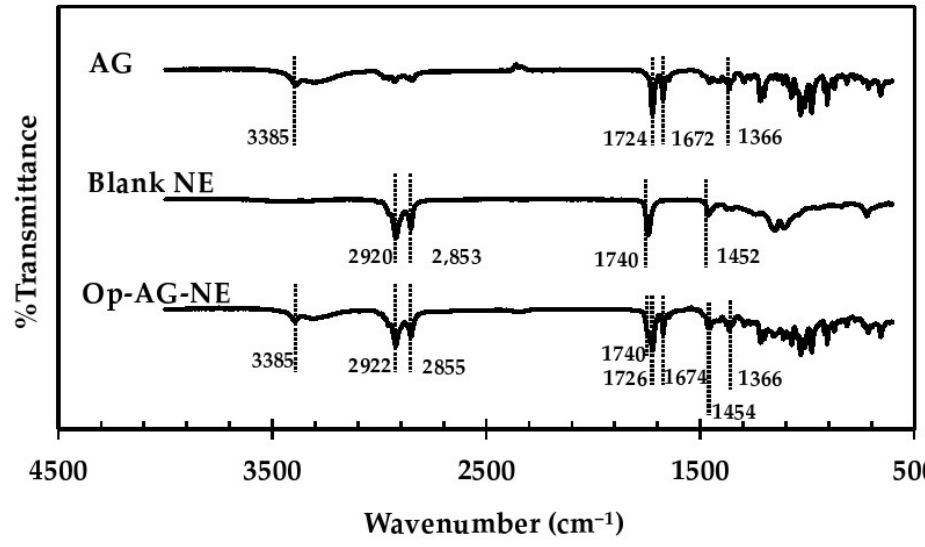
Figure 3. FT-IR spectra of AG, Blank NE and Op-AG-NE.